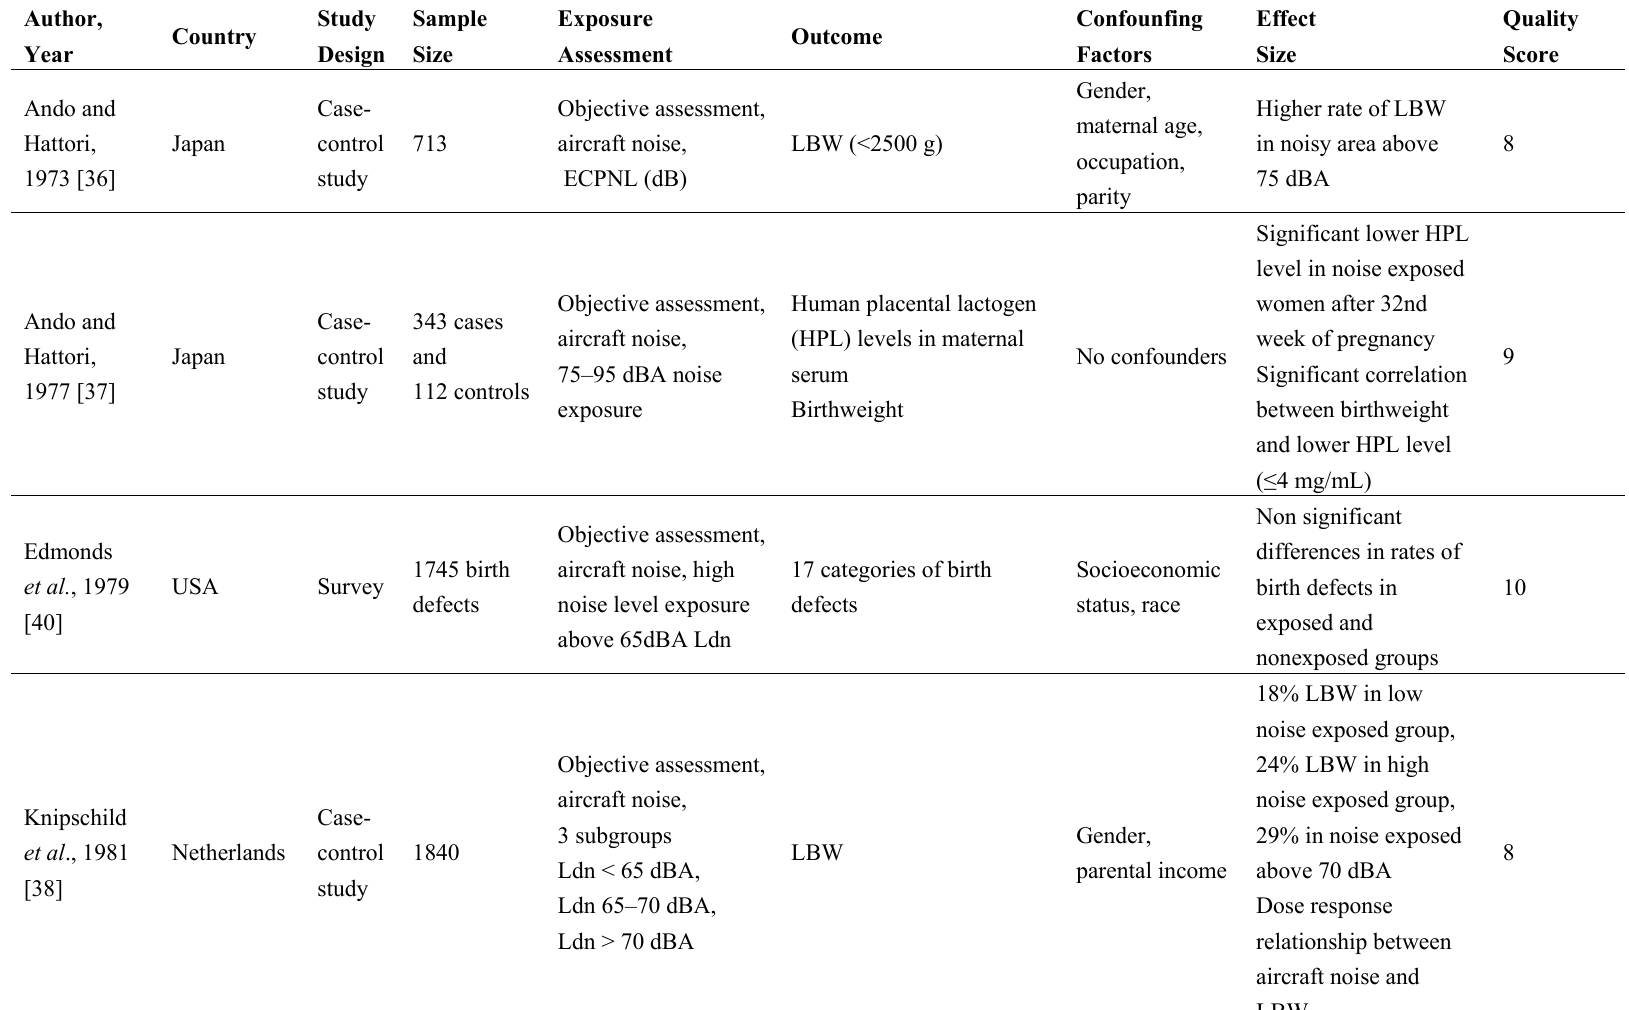
Table 2. Summary of epidemiological studies on environmental noise exposure and reproductive outcomes (ordered by year of